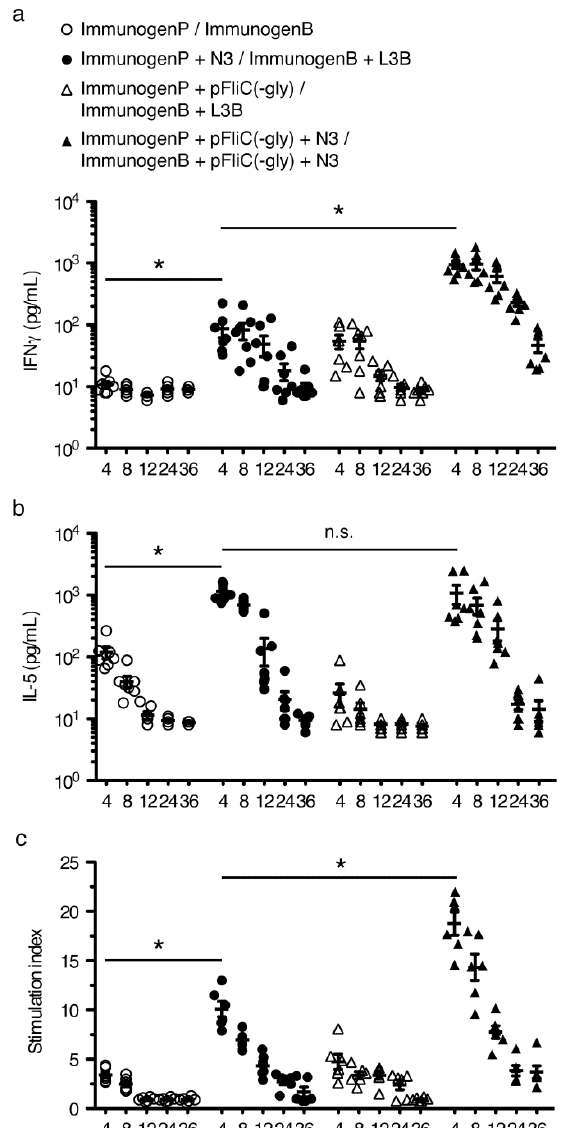
Figure 8. Kinetic analysis of T cell responses to immunizations with gp160 with and without adjuvant combinations. ( a ) Anti-mIFN ELISA was performed on cells restimulated with rgp160. Values shown were adjusted for baseline values seen using identical stimulations using splenocytes from naive mice. Priming (ImmunogenP, plasmids) and boosting (ImmunogenB, rec proteins) groups are shown in the key. Immunization details are listed in Table 2; ( b ) Anti-mIL-5 ELISA was performed on cells restimulated with rgp160. Values shown were adjusted for baseline values seen using identical stimulations using splenocytes from naïve mice; ( c ) Proliferative response to stimulation with rgp160 defined as stimulation index relative to identical stimulations using splenocytes from naïve mice. Statistical analyses were conducted using a two-tailed unpaired Student t test. * Differences of the responses between compared groups at week 4 after final boost defined as p ≤ 0.05 were considered significant. n.s. = non-significant. Comparisons between groups with the HIV-1 antigens were performed by using the non-parametric Mann-Whitney U test with Bonferroni correction, p < 0.05 was considered